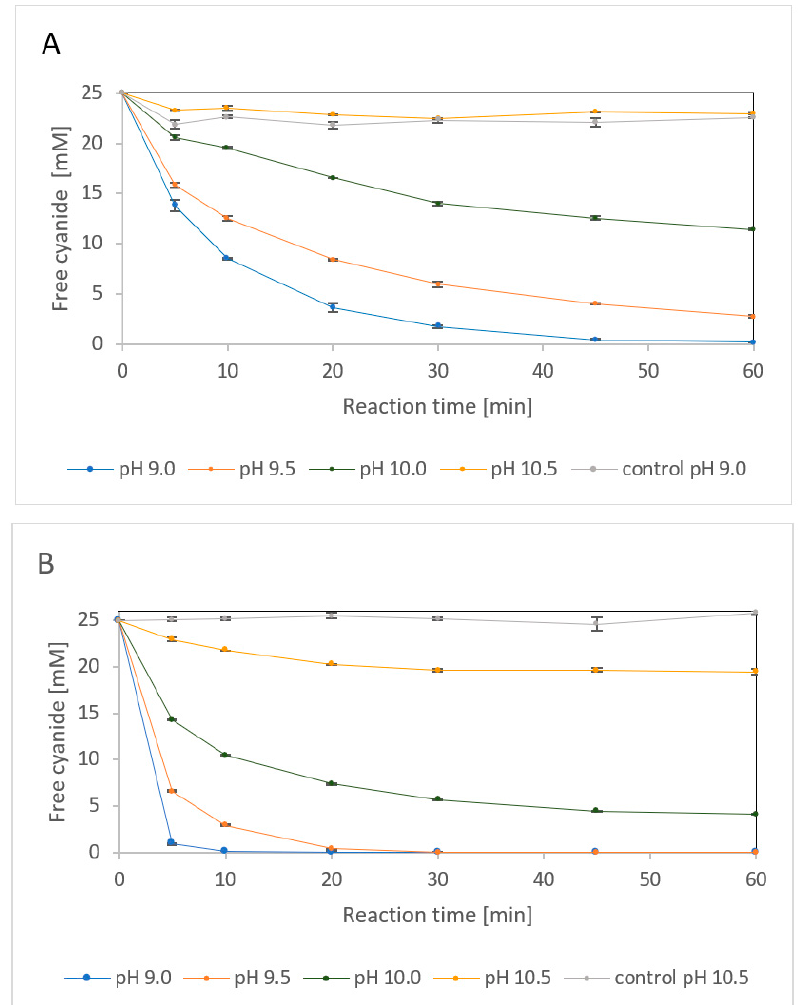
Figure 5. Effect of pH on the biocatalyzed degradation of 25 mM free cyanide (fCN) in 100 mM glycine/NaOH buffer by ( A ) 4.0 µg enzyme/mL and ( B ) 20 µg enzyme/mL. Controls were carried out at ( A ) pH 9.0 and ( B ) pH 10.5 without enzyme. Residual fCN concentration was determined by picric acid